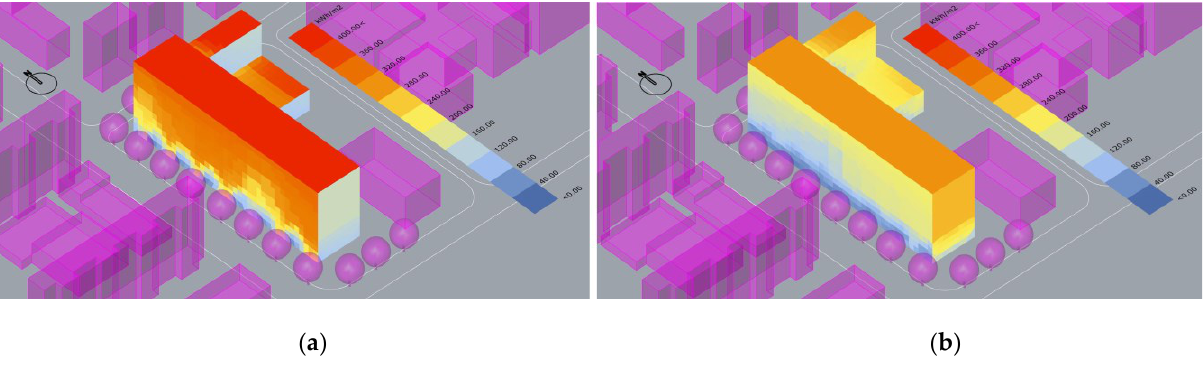
Figure 7. The radiation simulation of the tourist hotel on high-temperature days ( a ) and low-tem- perature days ( b ).